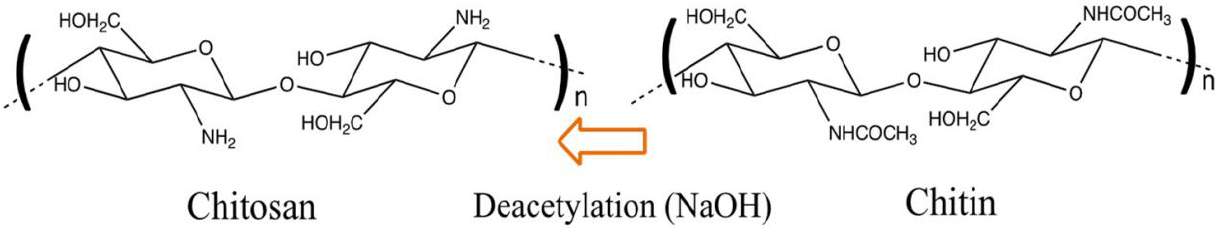
Figure 4. Production of chitosan after deacetylation of chitin via alkaline treatment [15].